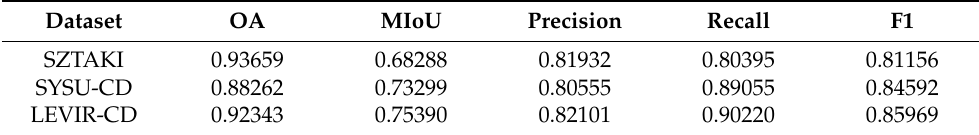
Table 4. The experiment results of STANet on three standard datasets.